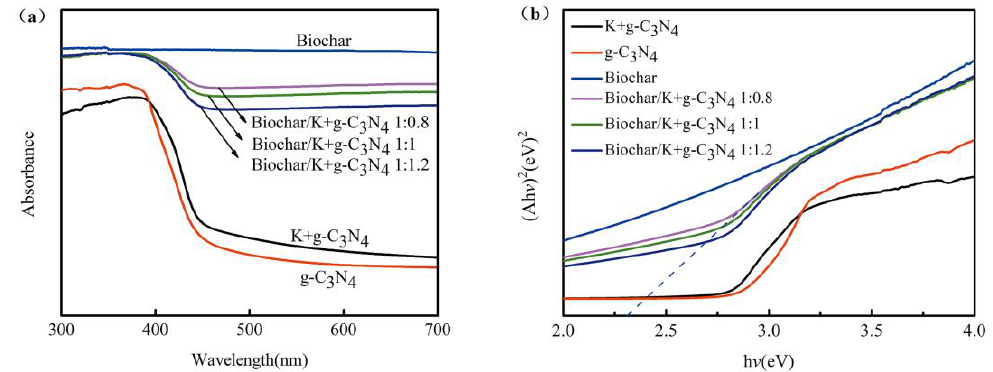
Figure 4. ( a ) UV-visible diffuse reflectance spectroscope (DRS) and ( b ) Tauc plots of biochar, g-C 3 N 4 , K-doped g-C 3 N 4 and biochar-supported K-doped g-C 3 N 4 .